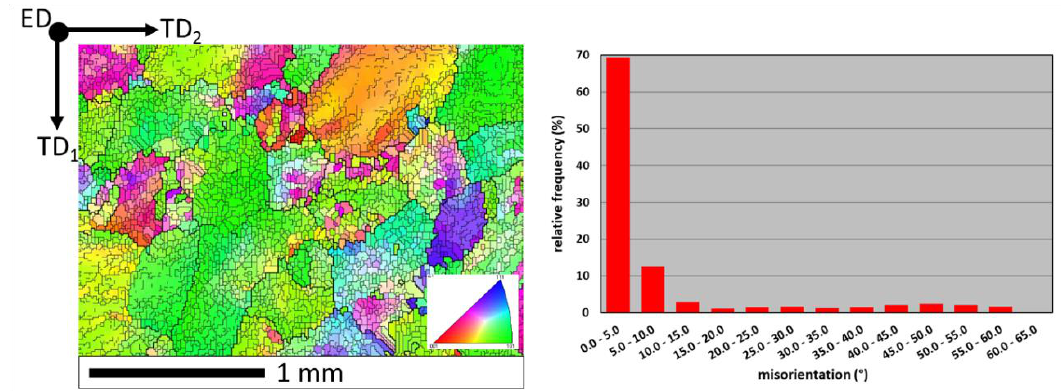
Figure 3. Orientation map and misorientation distribution for FeAl alloy after hot extrusion: thick lines – HABs (misorientation > 15°); thin lines – LABs (misorientation < 15°); color interpretation according to the stereographic triangle (red <001> direction, green <110> direction, blue <111> direction); TD 1 , TD 2 – orthogonal transverse directions; ED – extrusion direction.